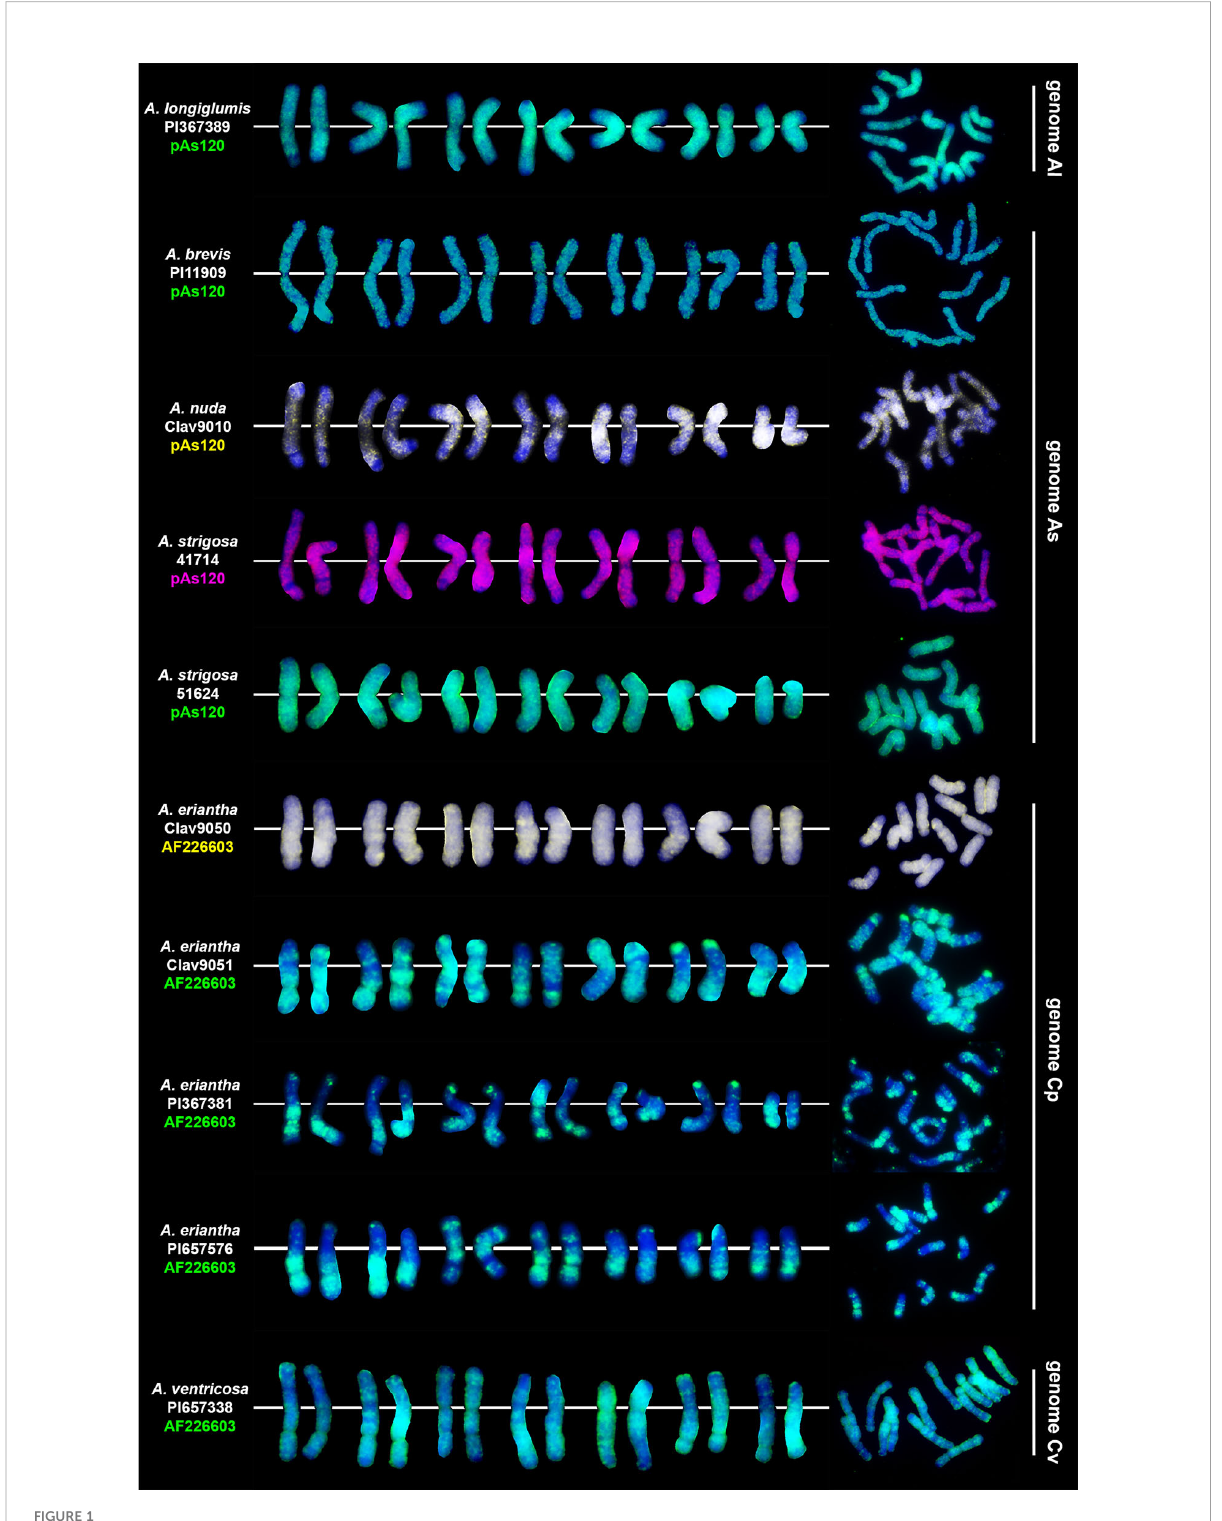
FIGURE 1 Chromosomal location of highly repetitive DNA motifs in diploid Avena species having genome constitution of A l , A s , C p and C v . Scale bar = 10 m